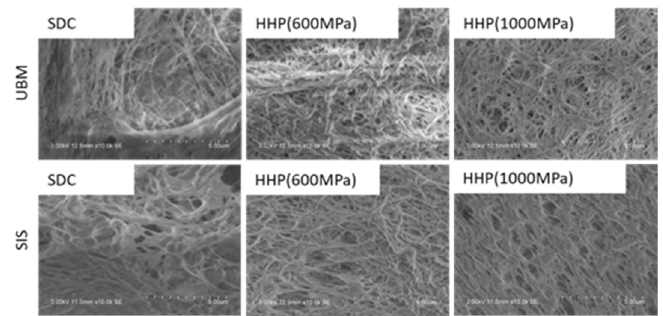
Figure 5. Scanning electron microscopy (SEM) analysis of the surface of d-ECM hydrogels at 0.8%. Scale bar: 5 µm. SDC and HHP represent the method of decellularization of each tissue (urinary bladder matrix (UBM) and small intestine submucosa (SIS)).